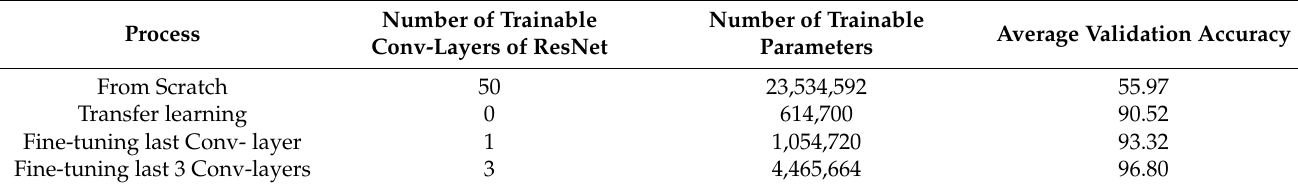
Table 3. Comparison of training results of the ResNet-50 muzzle pattern identifier model under varying number of trainable